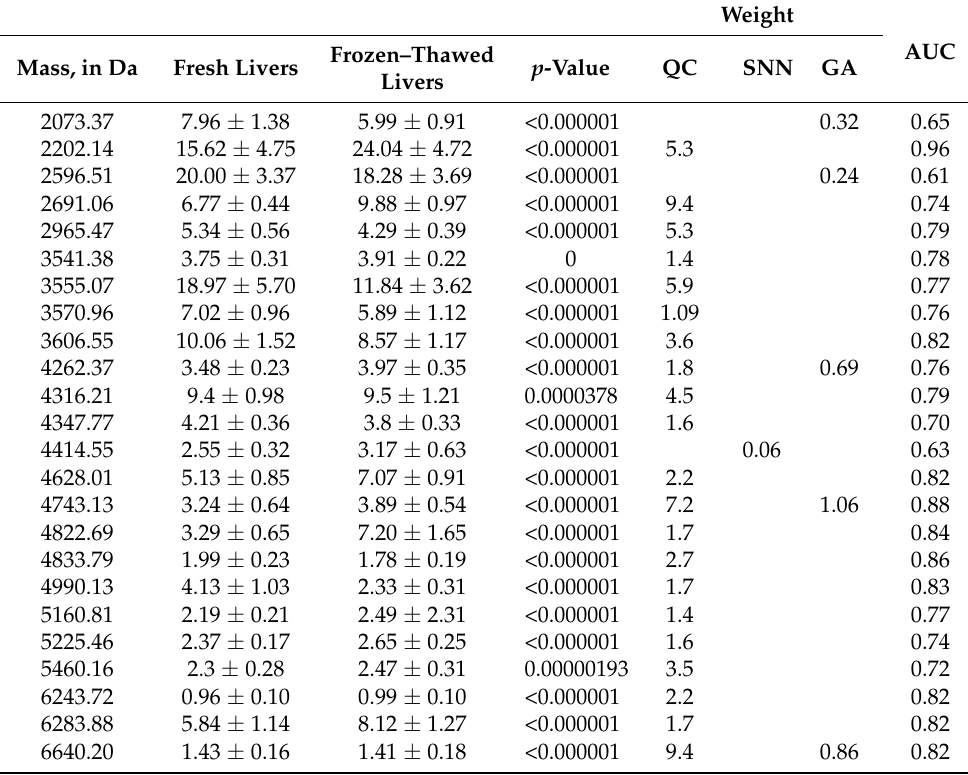
Table 2. A list of peaks involved in the calculation of the discrimination of fresh and frozen–thawed livers. Mass, in Da Fresh Livers